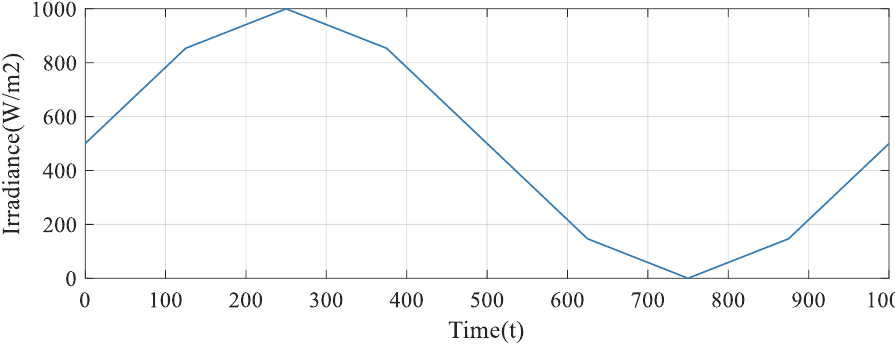
Figure 19. Fluctuation in light intensity in Example 2. The output voltage of DC bus in Example 2 is shown in Figure 20.